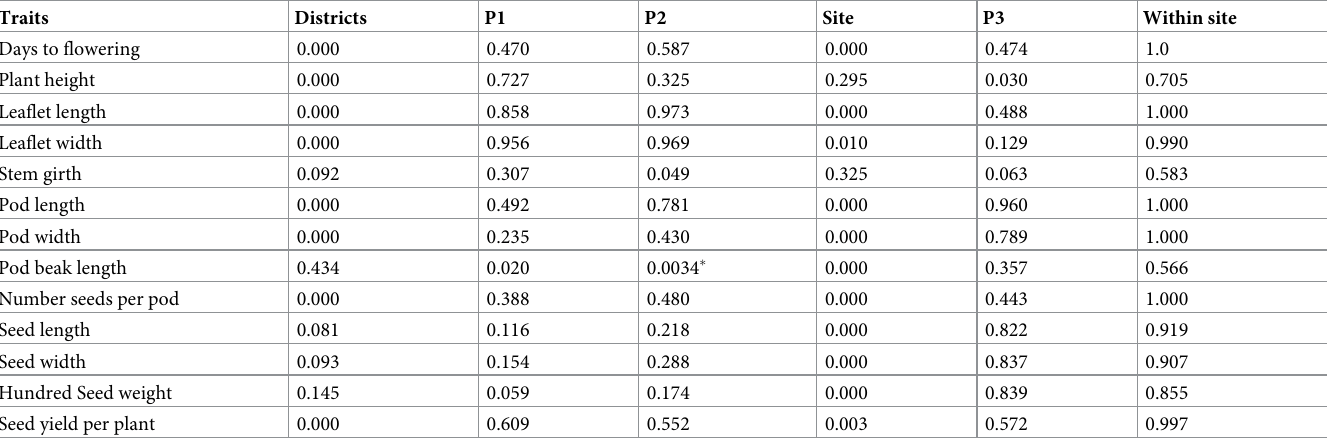
Table 4. Variance components (proportion of variance explained) for different levels of geographic variation for 13 morphological traits.